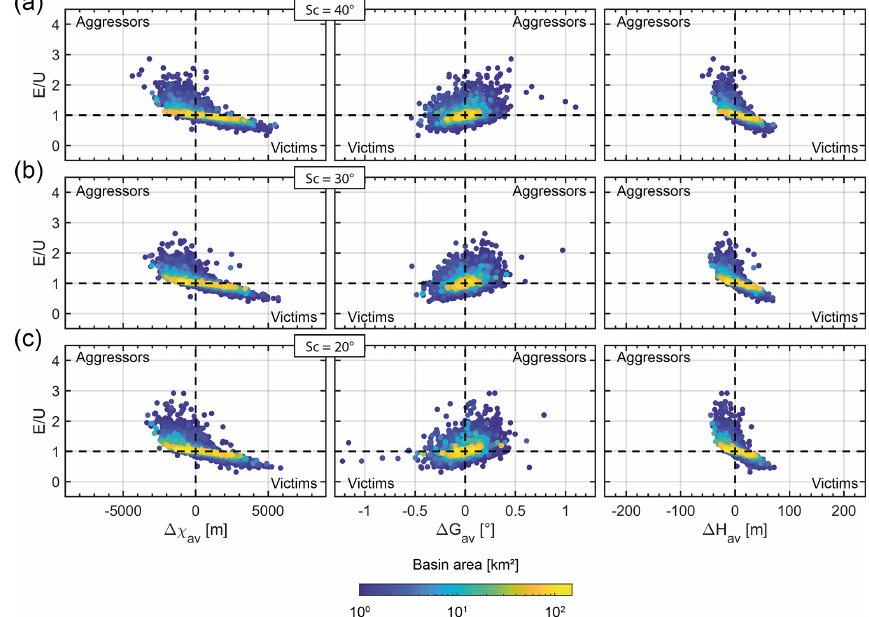
Figure 11. Effect of critical slope. Colour scale indicates basin area. Basins of variable sizes are sorted into seven area classes expanding geometrically with a multiplying factor of 2 from 1–2 to 64–128km 2 , every 0.5Myr over the time period 5–10Myr. Basins with a confidence index lower than 50% are discarded from the analysis. (a) Results with a critical slope of 40 ◦ . (b) Results with a critical slope of 30 ◦ (reference model). (c) Results with a critical slope of 20 ◦